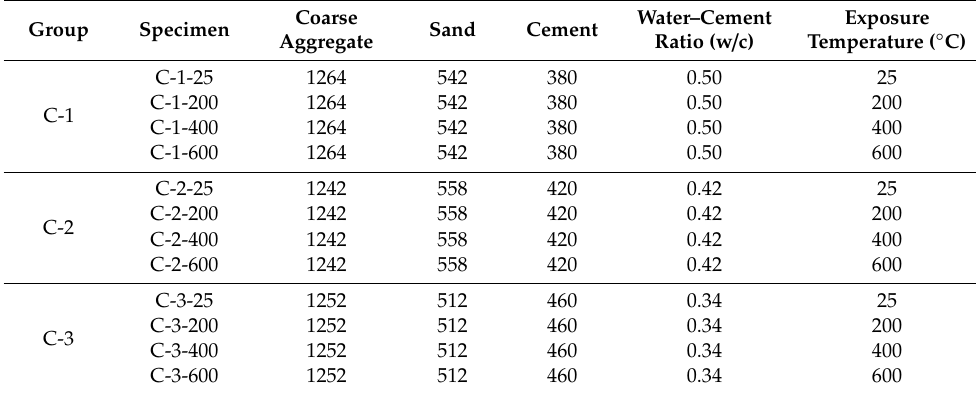
Table 1. The details of specimens.